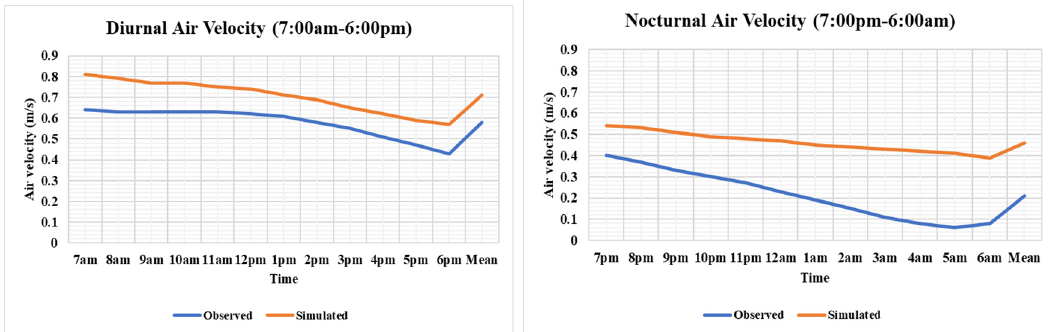
Figure 4. Measured and simulated results of diurnal and nocturnal air velocity at FBTS.